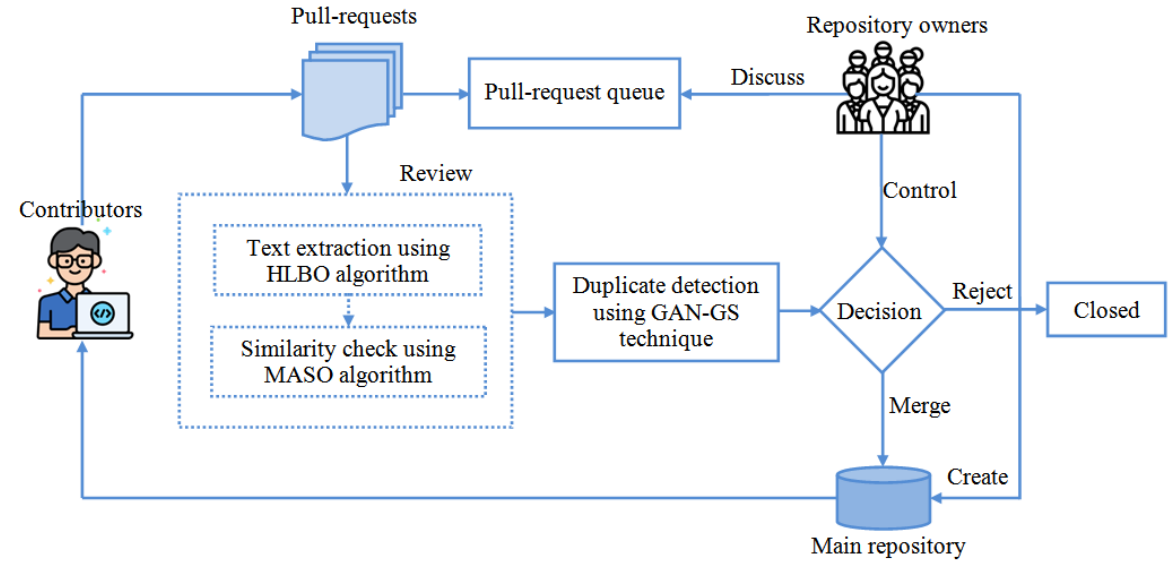
Figure 1. An overview of system design of proposed HDL-ODPR method.